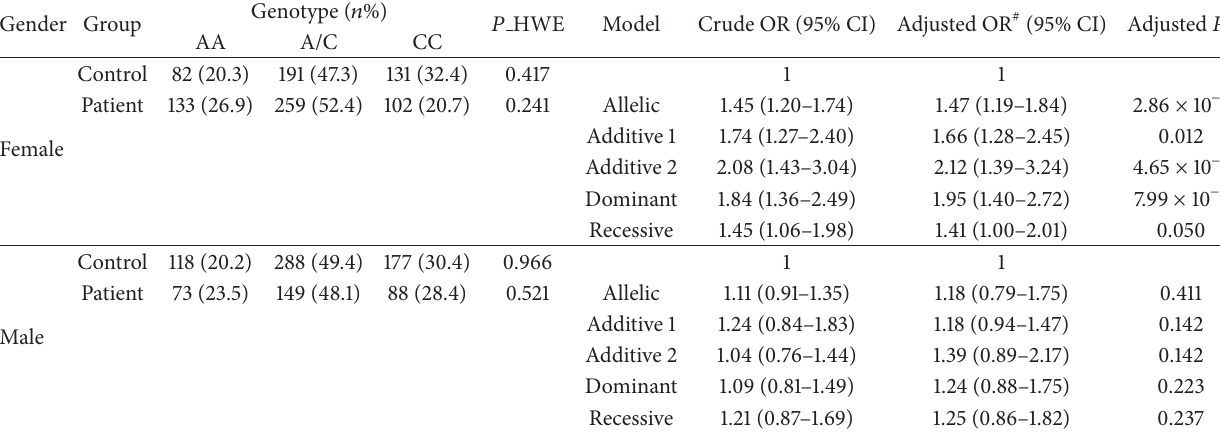
Table 4: The association between HM and rs9307551 was